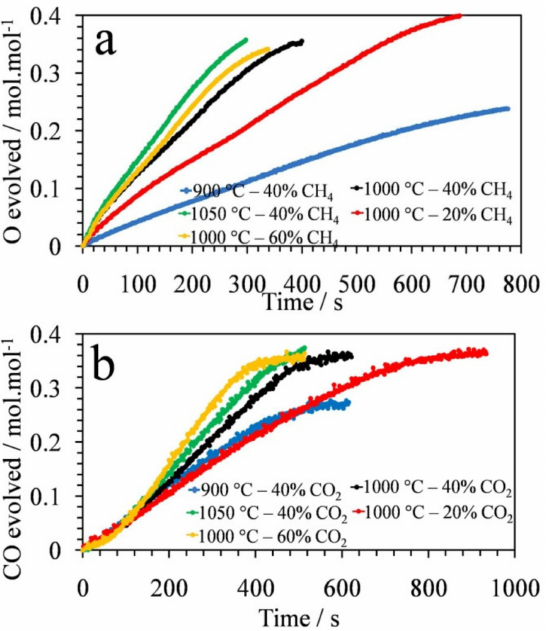
Figure 2. Experimental O ( a ) and CO ( b ) evolution profiles as a function of time at selected tempera- tures and reactant partial pressures over CeO 2 oxygen carriers performed in a solar reactor using concentrated solar